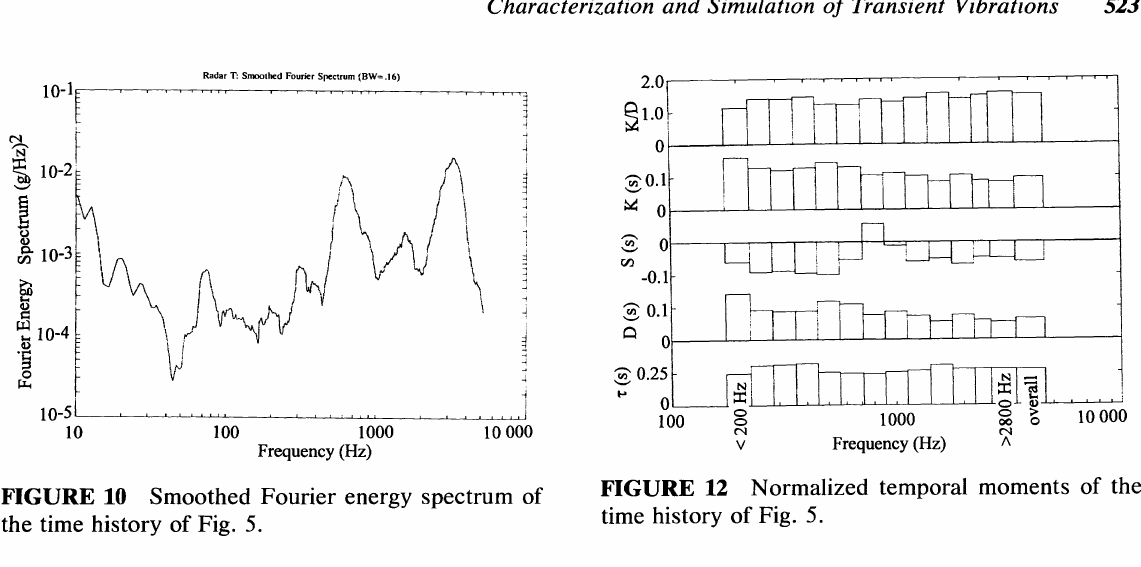
FIGURE 10 Smoothed Fourier energy spectrum of the time history of Fig. 5.